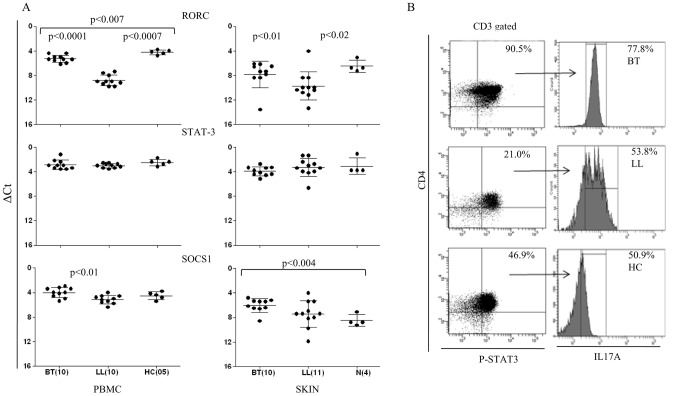
RORC, STAT3, SOCS1 expression in antigen stimulated PBMC and Skin lesions of leprosy and healthy subjects.A. Scattergram of Mean ΔCt ± SD of gene expression shows significant increase in RORC in healthy as compared to BT, Within leprosy types BT showed significantly higher RORC expression as compared to LL. Expression of STAT3 was similar in the 3 groups, and SOCS1 showed moderate and significance increase in BT as compared to healthy contacts as indicated by the p values in the figure. B. Phosphorylation of STAT3 is associated with intracellular IL-17 A in CD4+ cells as shown by multi-color flow cytometry analysis of antigen stimulated PBMC. Of the P-STAT3 cells BT showed higher % of IL-17A+ cells as compared to LL and healthy subjects as indicated in the upper quadrant. Abbreviations and legend as in figure 4.